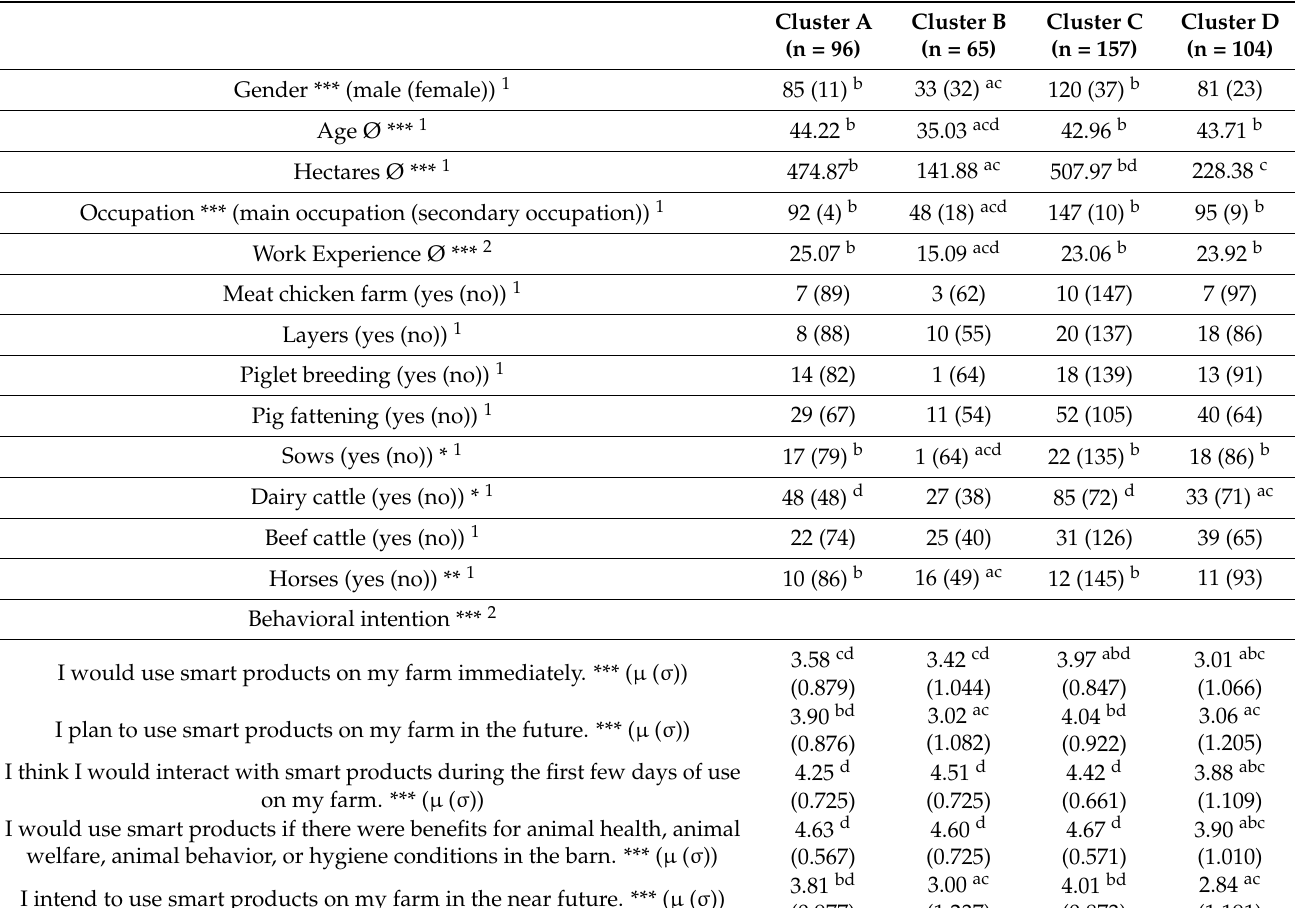
Table 3. Socio-demographic and farm characteristics of the